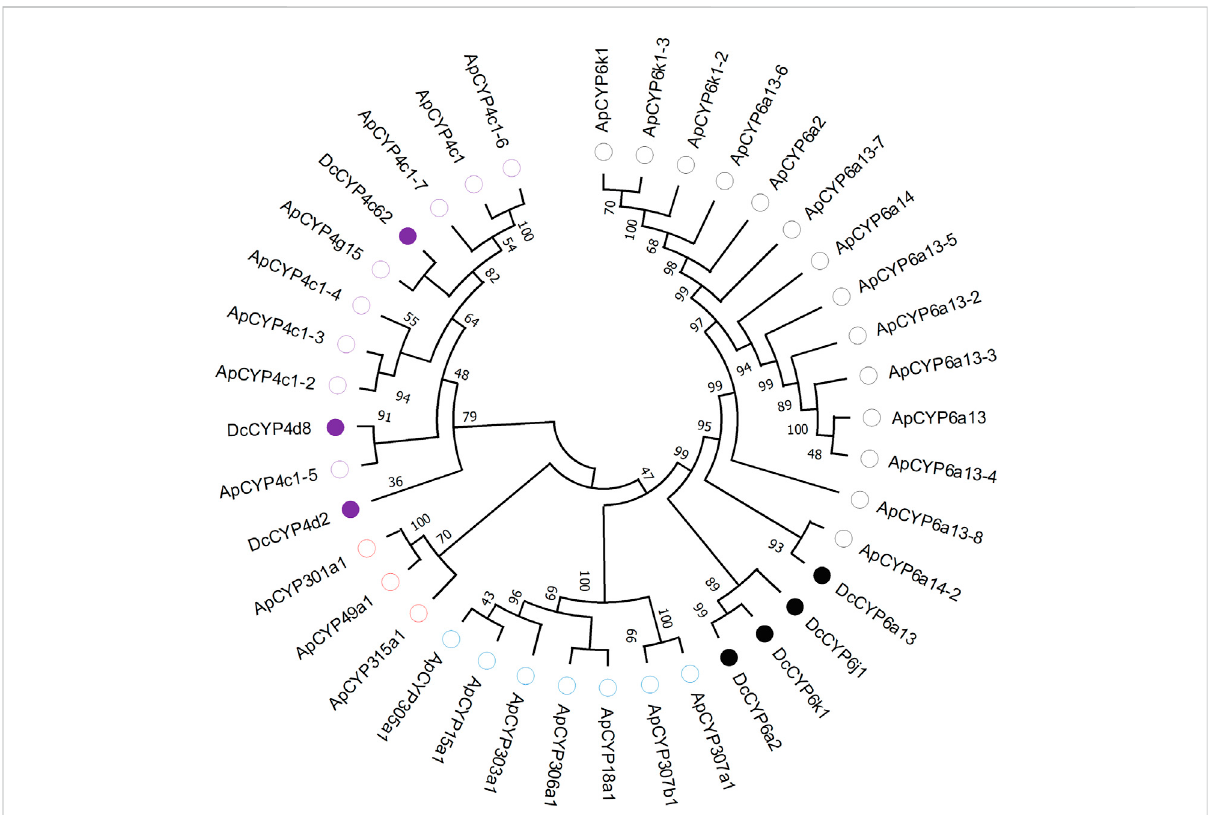
FIGURE 4 Phylogenetic relationship of 39 CYP proteins from D. citri (Dc, 7) and A. pisum (Ap, 32). Amino acid sequences were completely aligned using ClustalX 1.83, and a maximum likelihood tree was constructed using MEGA 11. Bootstrap values are shown at the branch points and indicate support as a percentage of 1,000 replicates. Seven D. c itri CYPs are marked with fi lled circles. The reference CYPs from A. pisum are marked with empty circles. CYPs assigned to CYP2-, CYP3- and CYP4-subclass are labelled by blue, black and purple circles, respectively. Three mitochondrial CYPs are marked by red circles. GenBank accession numbers for the CYP used in phylogenetic analysis are provided in Supplementary Table